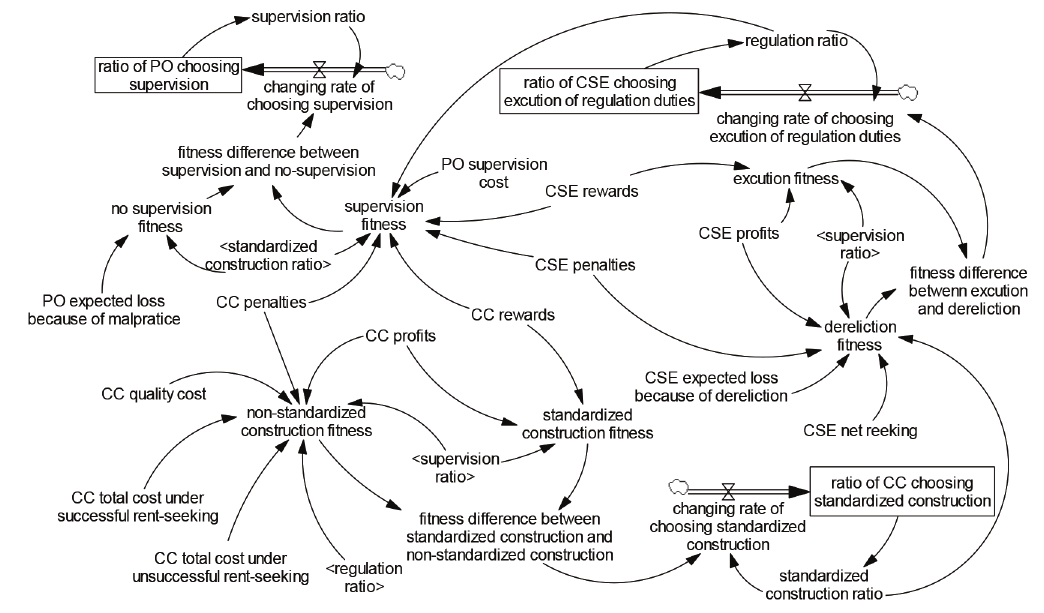
Figure 3. Evolutionary game SD model of construction quality supervision